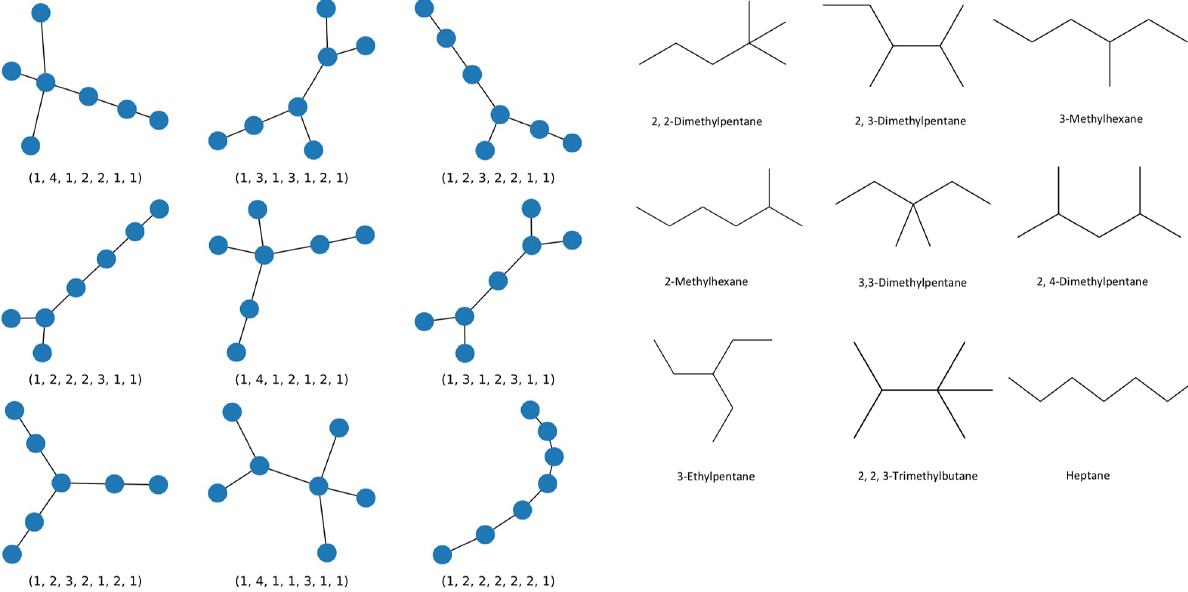
Fig 4. Heptane isomers. Created graphs and corresponding isomers for Heptane ( C 7 H 16 ) Left: Returned graphs with degree sequences, Right: Isomers of Heptane.